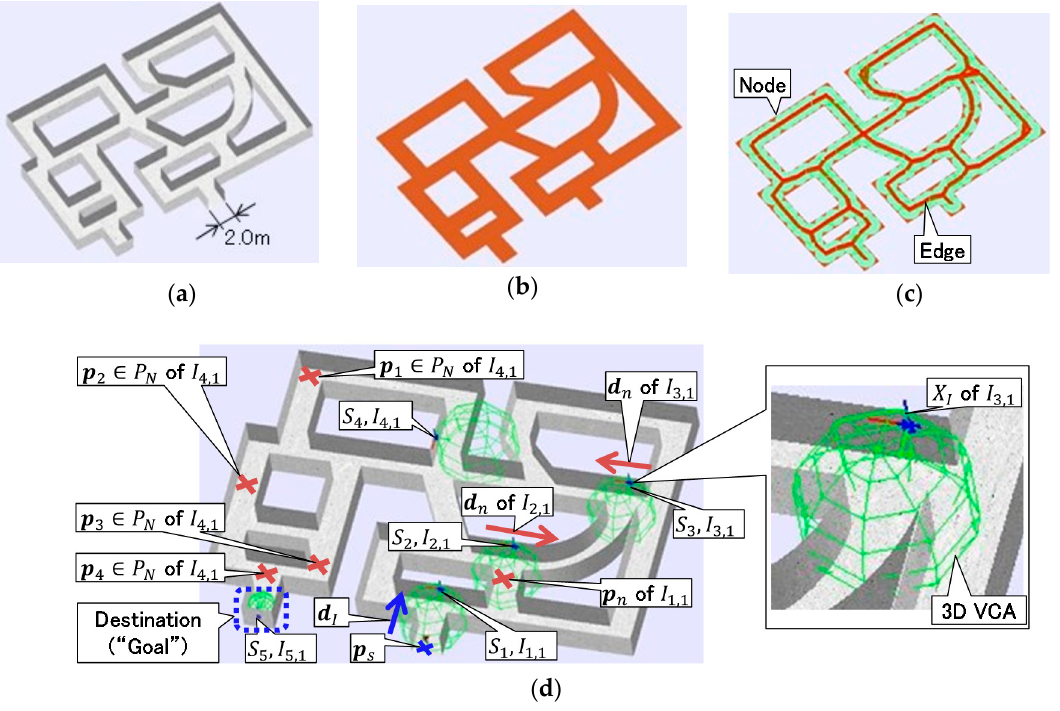
Figure 10. Environment model of virtual maze: ( a ) Textured environmental geometry G I (#vertices: 4,241,573, #faces: 8,436,885); ( b ) walk surface points W S ; ( c ) navigation graph G N ; ( d ) wayfinding scenario. The results are available in the supplementary video file. Table 4. User-specified wayfinding scenario.